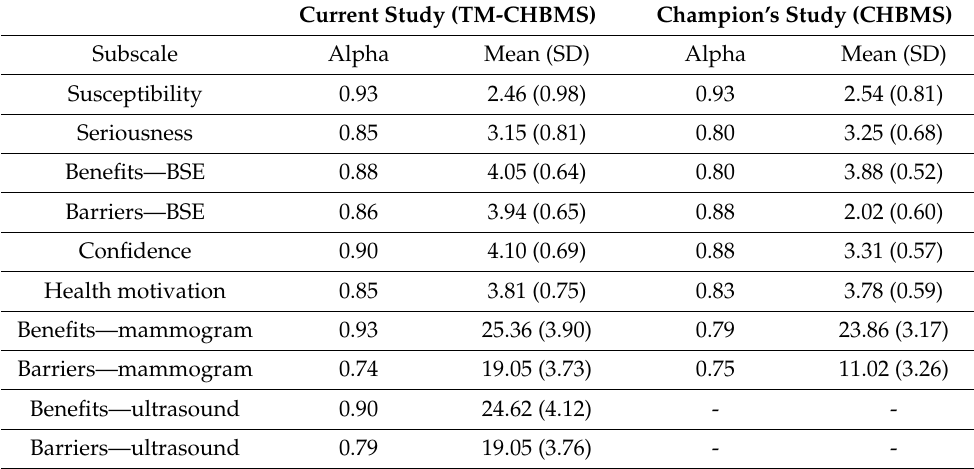
Table 2. Comparison of the Original Champion Health Beliefs Model with the modified champion health belief model—Thai version.